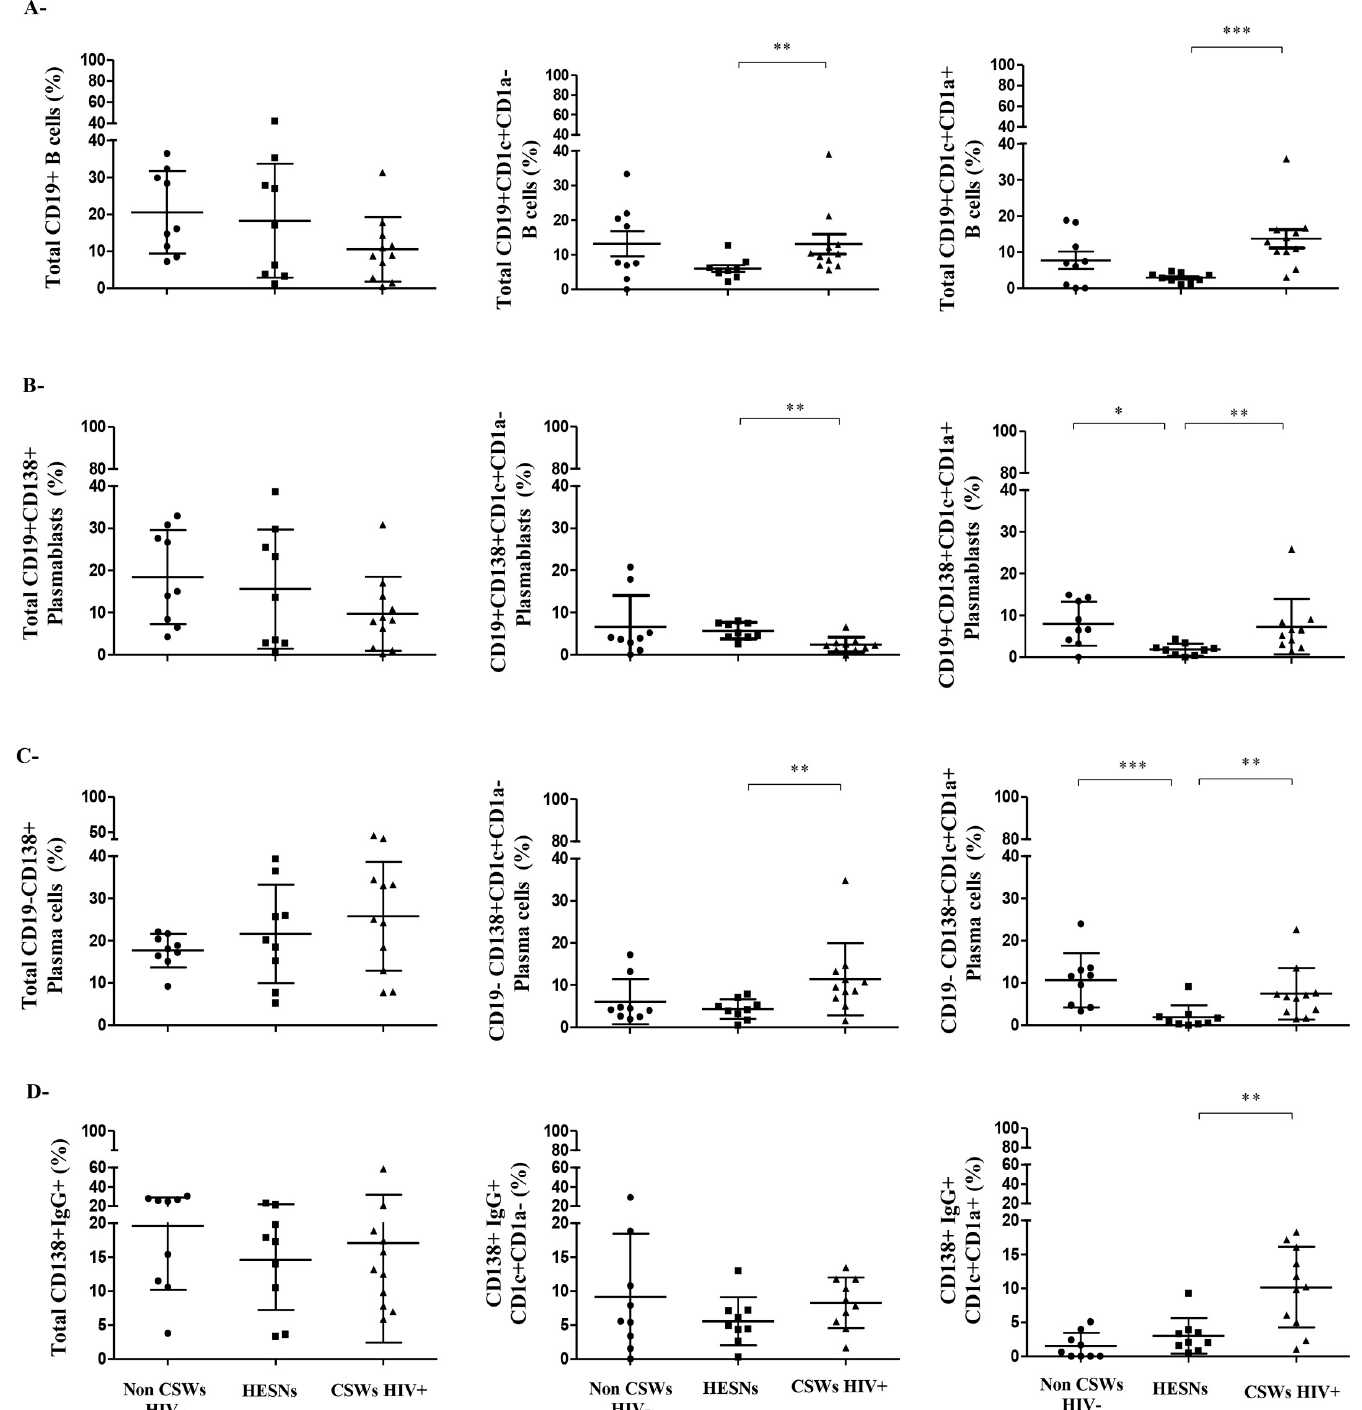
Fig 3. Frequencies of total B-cells, plasmablasts and plasma cells in the cervicovaginal lavage (CVL) cellular fraction of HIV-1 uninfected non-CSW, HESN and HIV-1 infected CSW women. Flow-cytometry analysis of (A) total CD19+ (left panel), CD19+CD1c+CD1a- (middle panel), and CD19+CD1c+CD1a+ (right panel) B- cells, (B) total CD19+CD138+ (left panel), CD19+CD138+CD1c+CD1a- (middle panel) and CD19+CD138+CD1c+CD1a+ (right panel) plasmablasts, (C) total CD19-CD138+ (left panel), CD19-CD138+CD1c+CD1a- (middle panel) and CD19-CD138+CD1c+CD1a+ (right panel) plasma cells, (D) total CD138+IgG+ (left panel), CD138+IgG+CD1c+CD1a- (middle panel) and CD138+IgG+CD1c+CD1a+ (right panel) plasmablasts and plasma cells. Cells were gated on live CD45 + CDKPAN- cells and were negative for CD3, CD56 and CD66. Relative frequencies were calculated vs total live CD45+CDKPAN- cells (A,B,C and D) left panels, vs